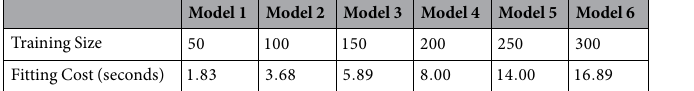
Table 3. Computational cost of fitting MRGP models in our convergence study: As the number of the training samples increases, the fitting cost increases as